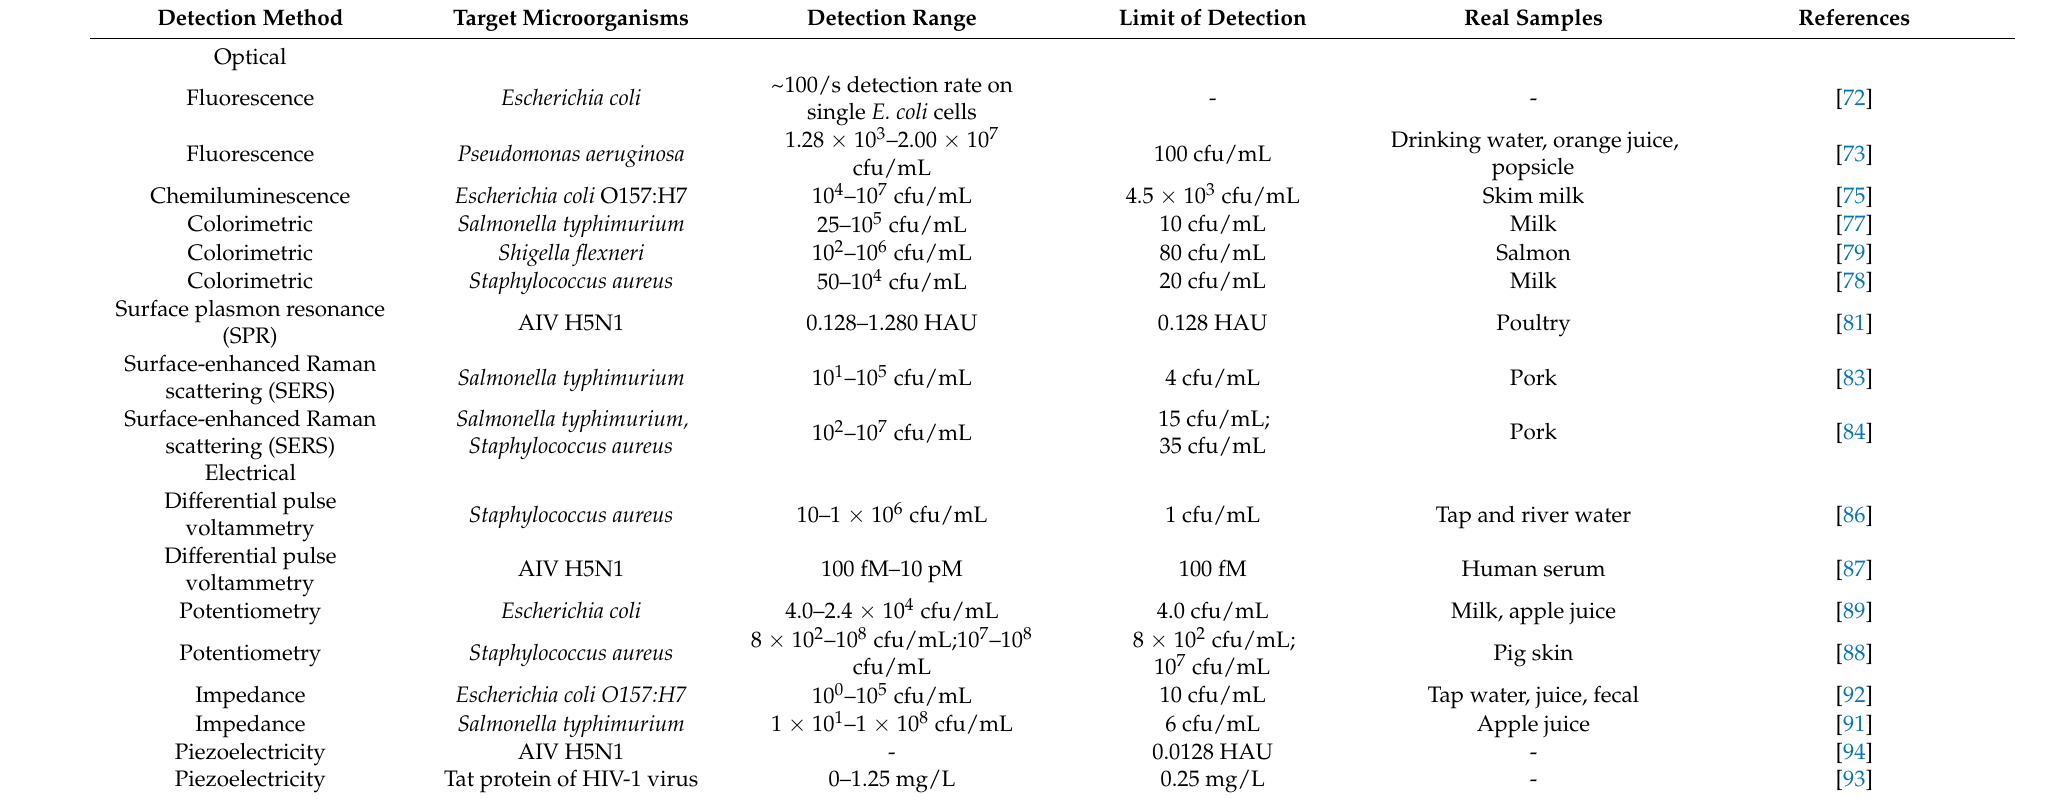
Table 2. Various detection methods by aptamer-based biosensors for microbial